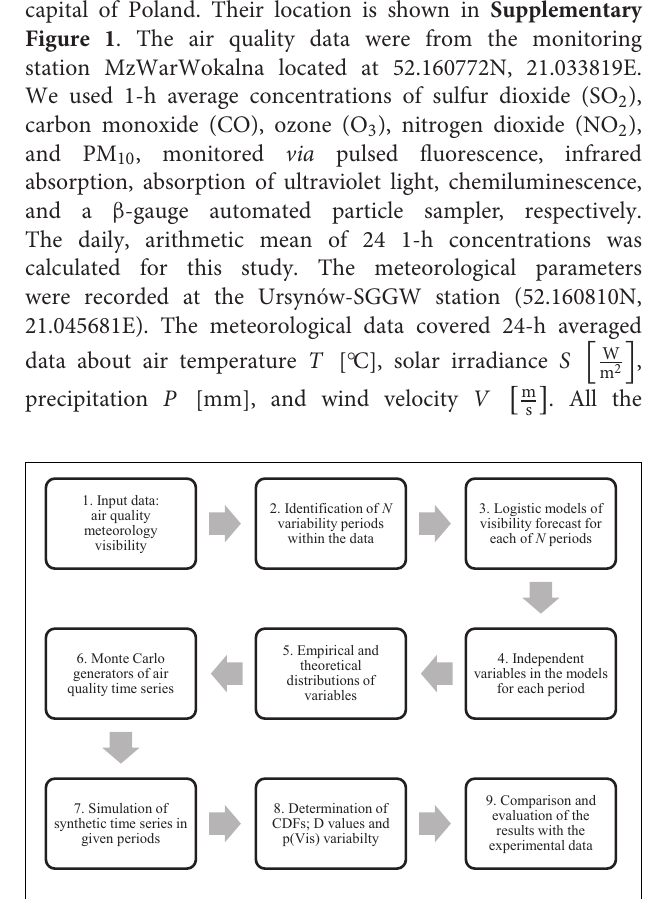
FIGURE 1 | The workflow of determination of probabilistic model of simulation of visibility